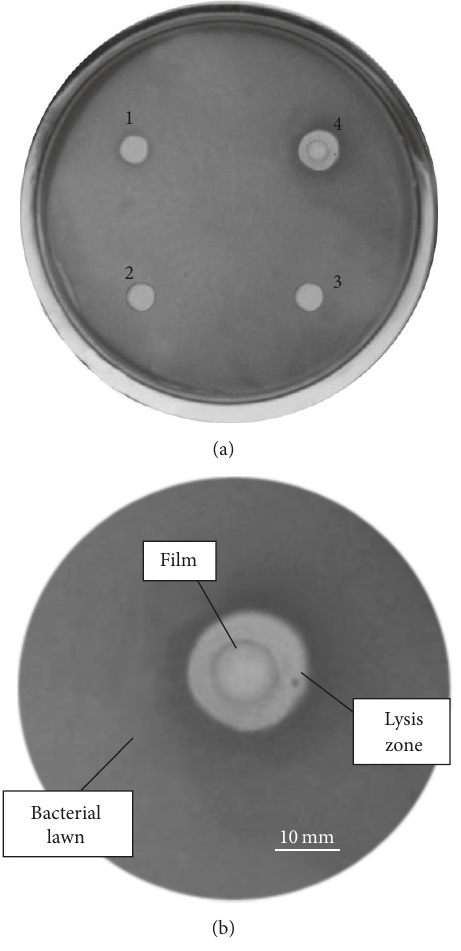
Figure 10: Effect of the filler concentration in the HEC/ organoben- tonite composite films on inhibition of S. aureus growth: (a) HEC/organobentonite composite films with various filler concen- trations, wt.%: 0 (1) , 0.5 (2) , 1 (3) , and 5 (4) ; (b) HEC/organoben- tonite composite film with 5 wt.% of filler (on an enlarged